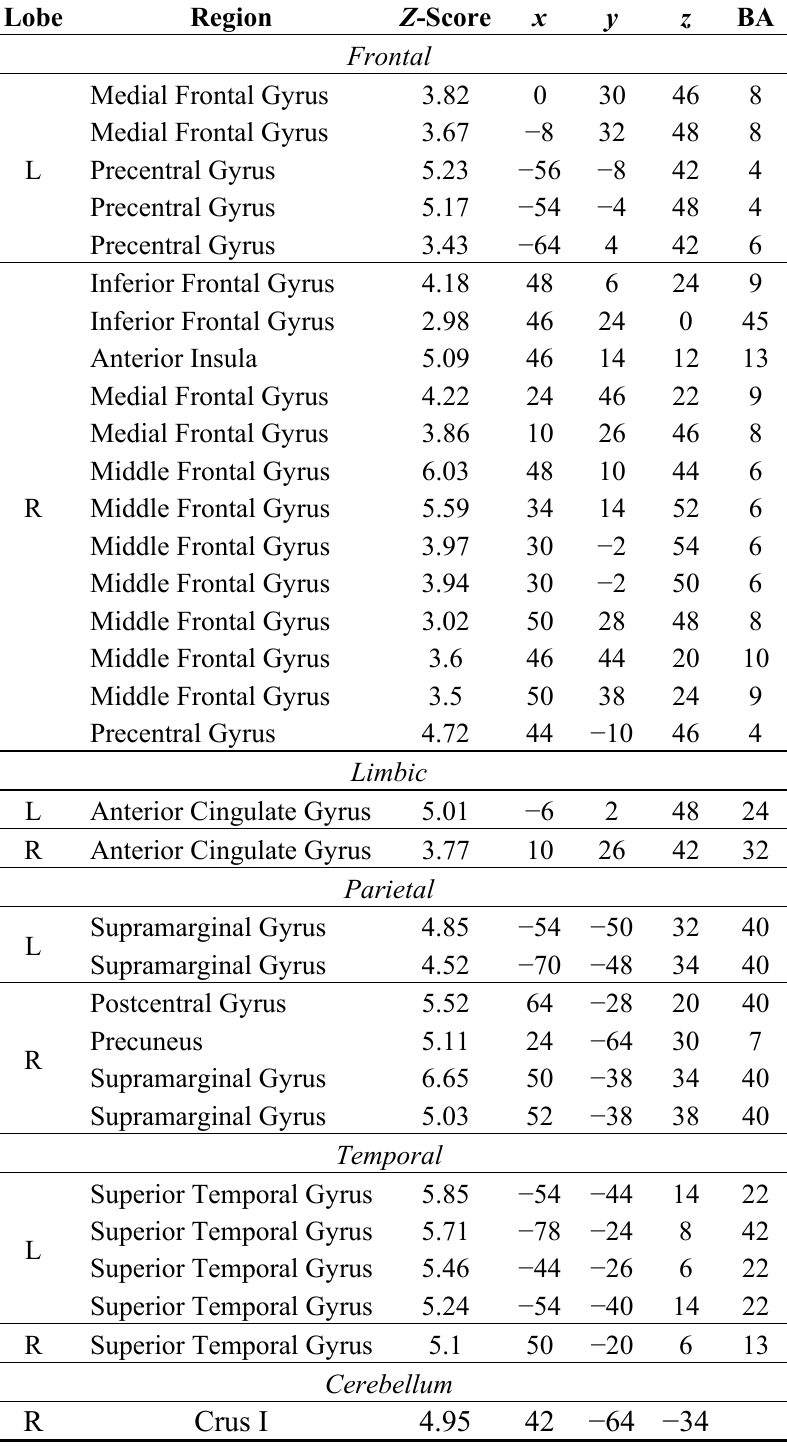
Table 1. Stereotactic MNI coordinates, Z -score values, and anatomical and Brodmann areas for activations during the Pattern, Meter and Tempo (combined) contrasted to